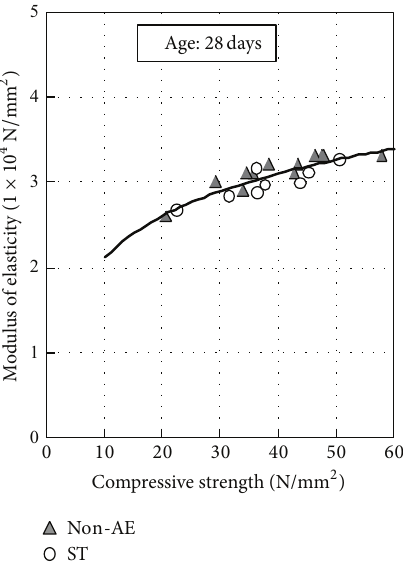
Figure 4: Relationship between compressive strength and modulus of elasticity.